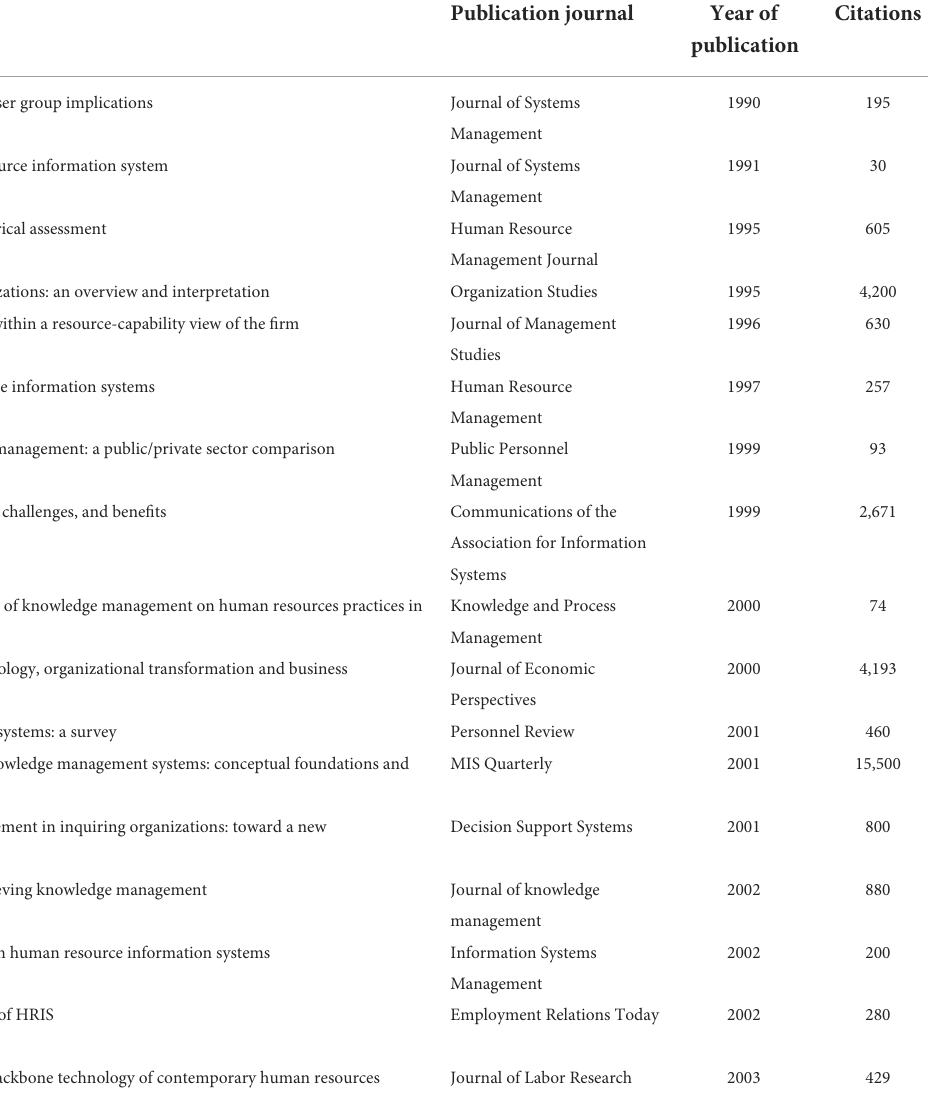
TABLE 3 Description of studies included in the review